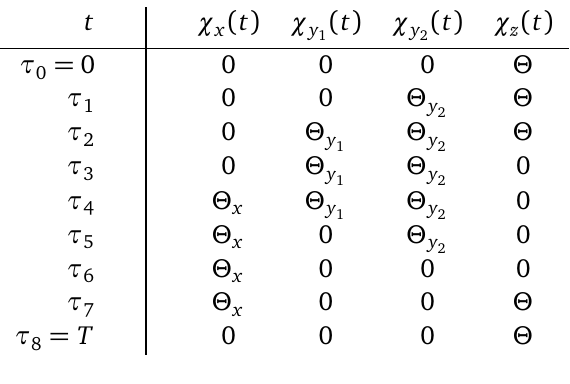
Table 2: Values of the coupling strengths χ α = 0,...,8) along the closed loop in the four-dimensional parameter space.